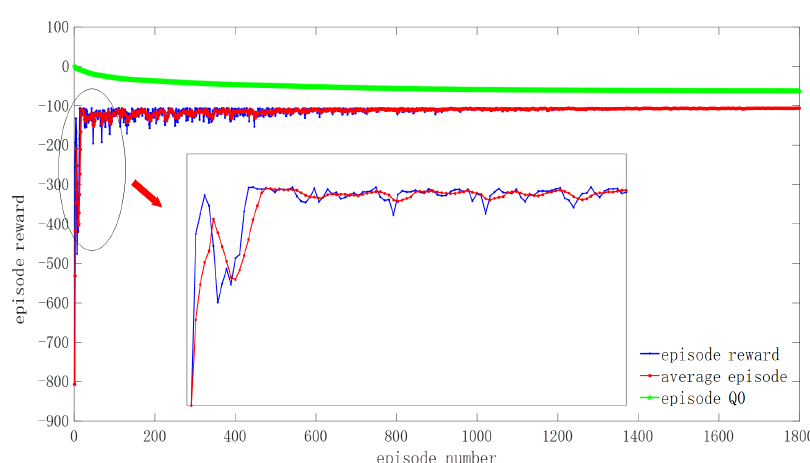
Figure 7. Undisturbed training chart.